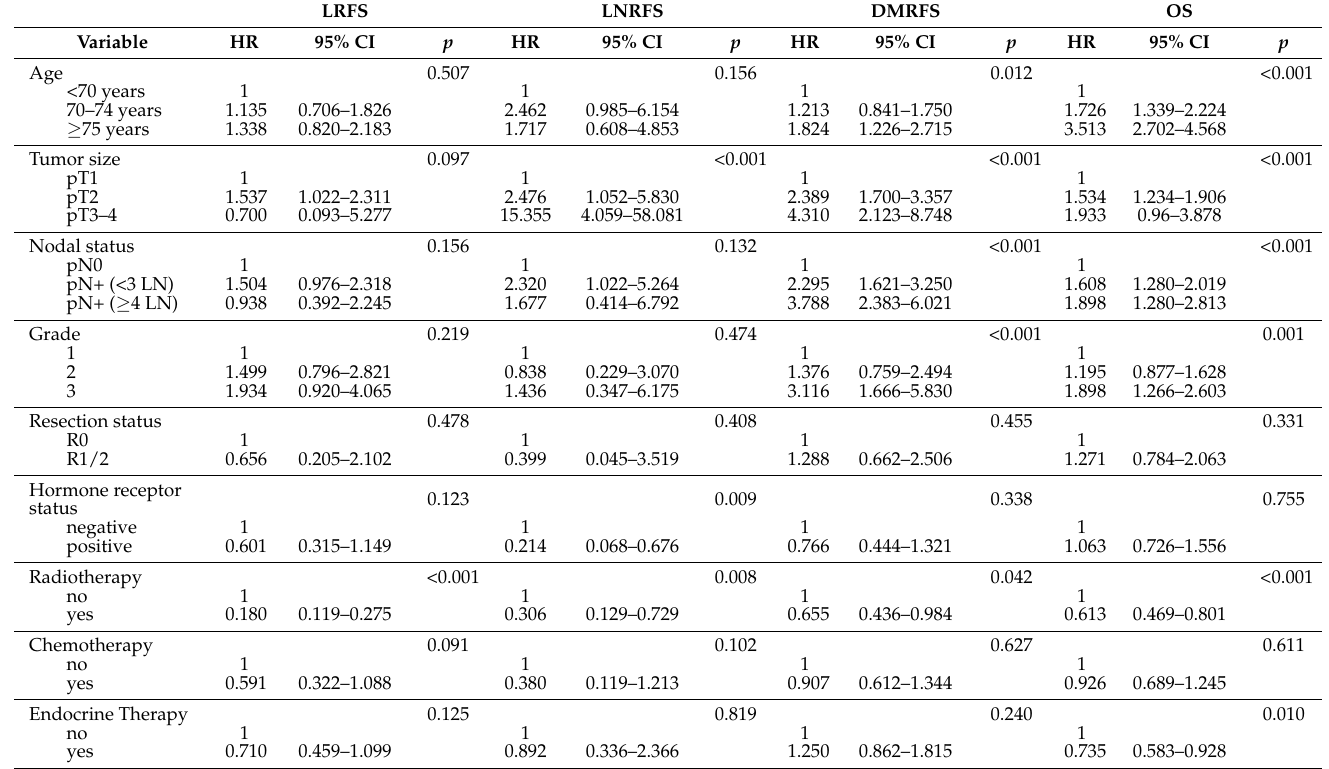
Table 4. Multivariate Cox regression analysis for loco-regional recurrence-free survival (LRFS), lymph node recurrence-free survival (LNRFS), distant metastasis-free survival (DMRFS), and overall survival (OS) for patients with invasive carcinomas who underwent breast-conserving surgery ( n =